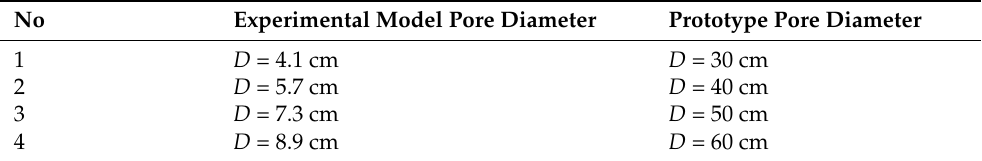
Table 3. Diameters of the physical test cases.